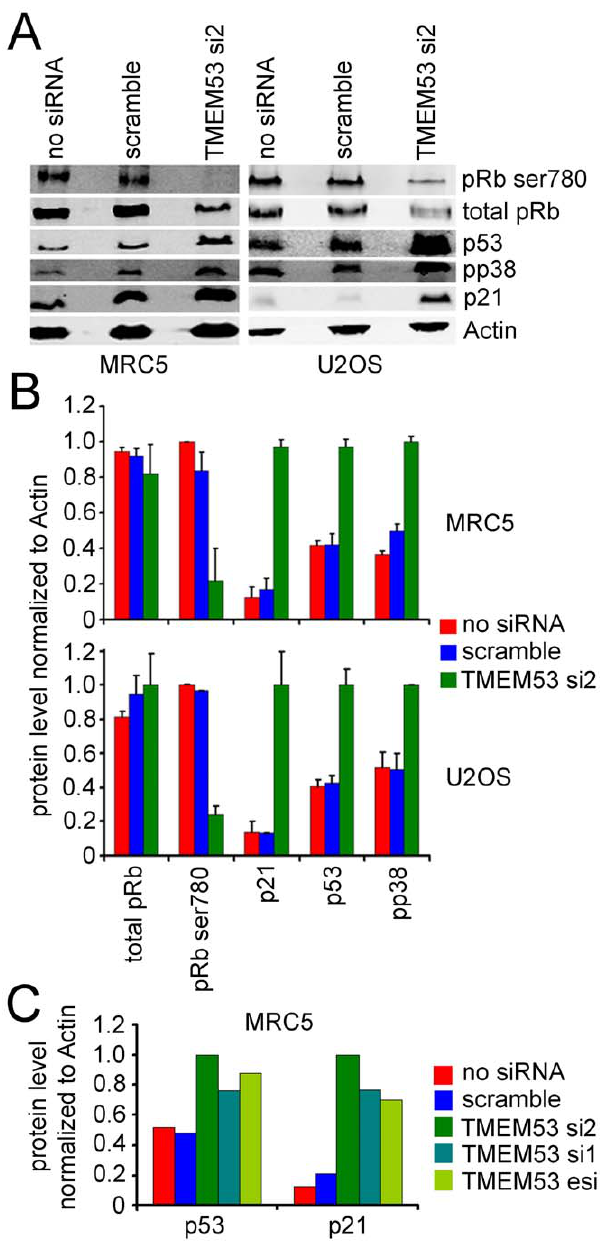
Figure 8. NET4/TMEM53 knockdown alters levels of several cell cycle proteins. Protein lysates were recovered from both MRC5 and